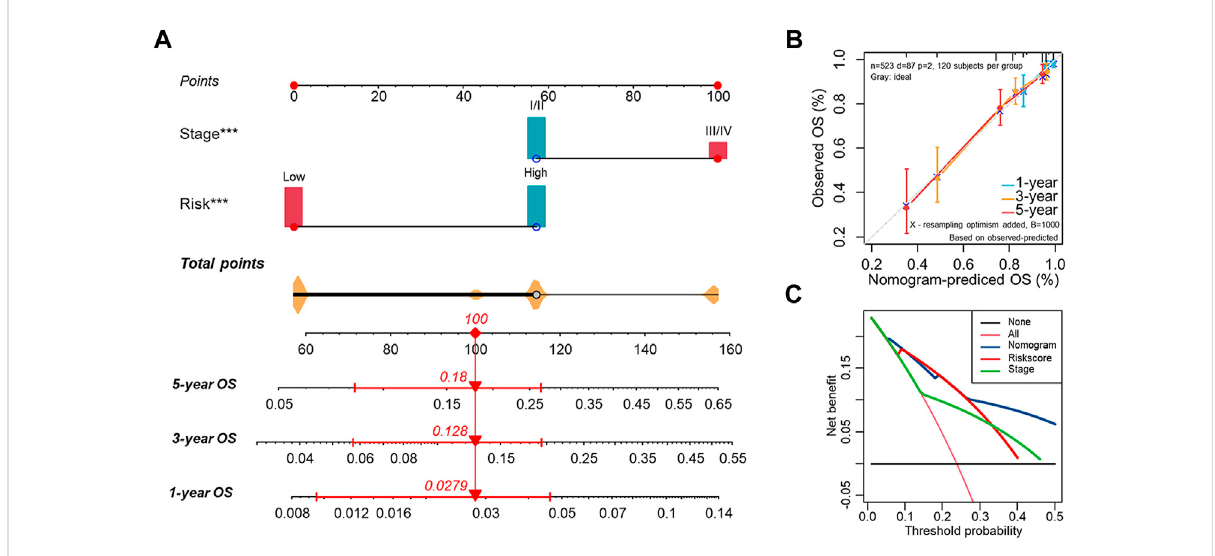
FIGURE 8 Establishment of the nomogram for predicting OS of endometrial cancer patients in the entire cohort (A) The nomogram predicting the probability of the 1-/3-/5-year overall survival rate of UCEC patients. (B) The calibration curve for evaluating the accuracy of the nomogram model. The dashed diagonal line in grey color represents the ideal nomogram. (C) The decision curve analysis showing predicted 5-year OS based on the nomogram, the Risk. Score, and the